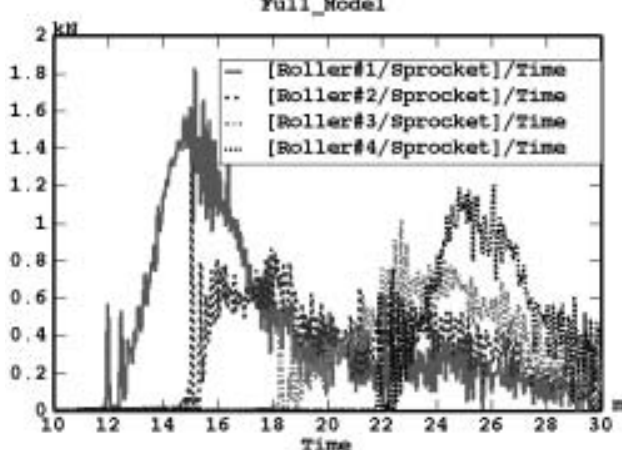
Fig. 12. Simulated contact force between rollers and driving sprocket using full model.